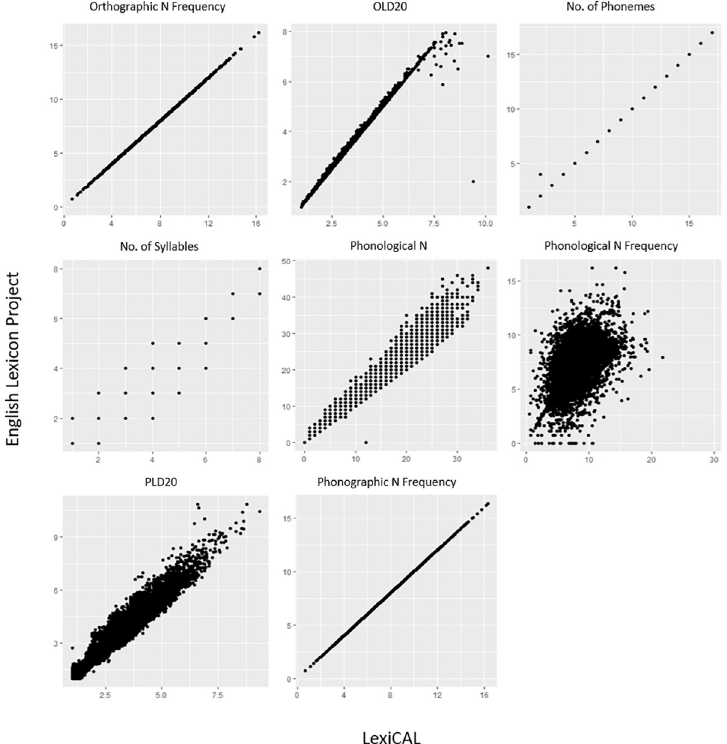
Fig 6. Scatterplots displaying the relationships between the data computed by LexiCAL, and the data from the English Lexicon Project. Scatterplots for word length, orthographic neighbourhood density, and phonographic neighbourhood density are not presented because the data were